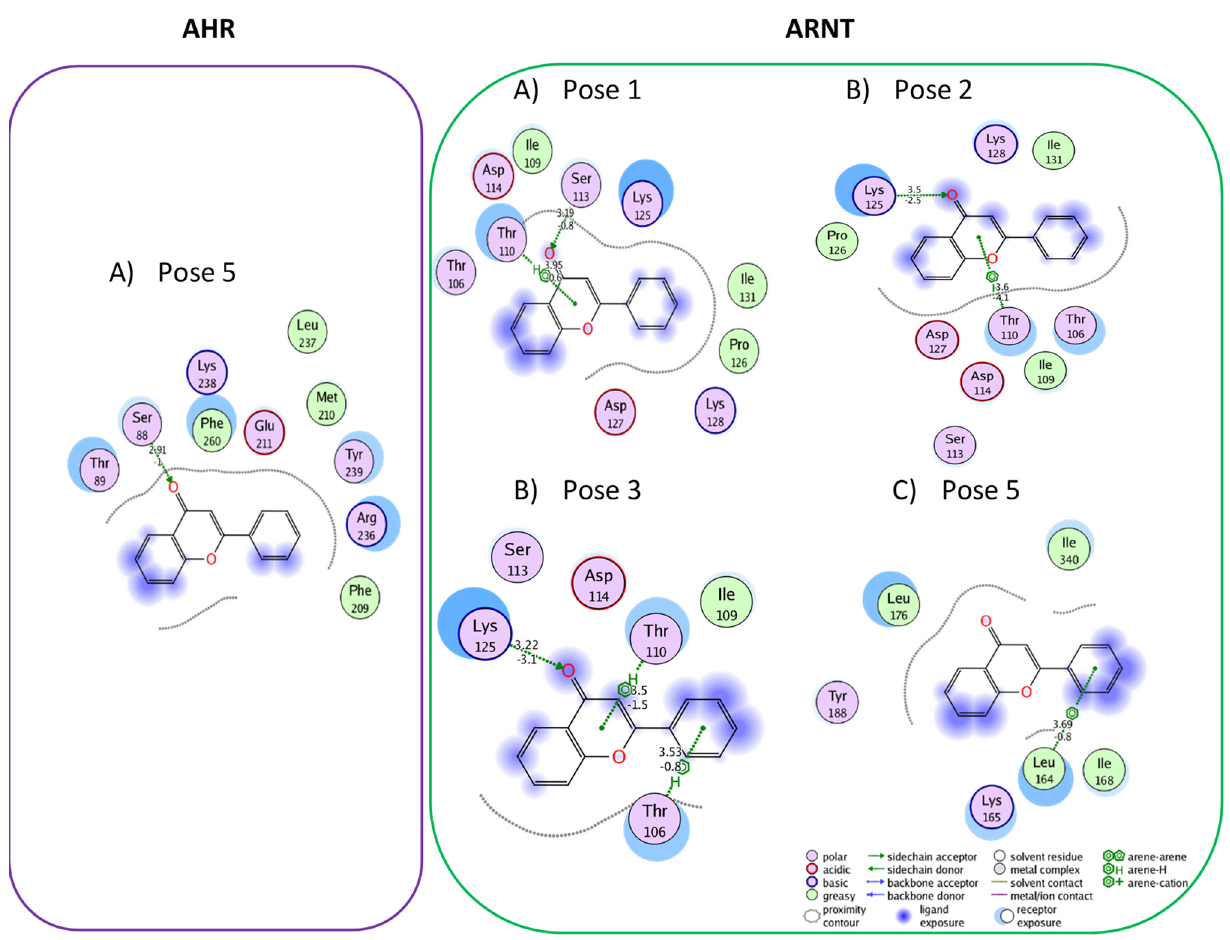
Figure 10. Interaction network between monomeric proteins AHR, ARNT and the studied compound 5 .